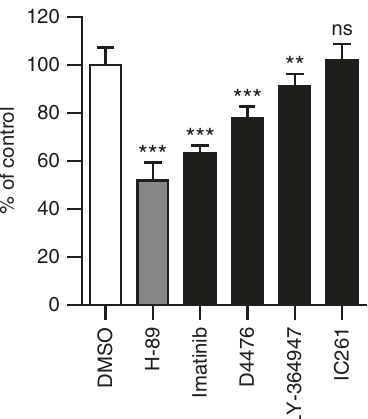
Fig. 1 Veri fi cation of host-directed Mtb inhibitors from literature in the novel screening assay. Overnight treatment of MelJuSo cells infected with Mtb constitutively expressing stable DsRed with compounds that were previously reported to be active against Mtb at 10 µ M or with DMSO at equal v/v. H-89 is used as a positive control at 10 µ M 16 . The Mtb bacterial load is displayed as a percentage of the DMSO control ± standard deviation to indicate the extent of bacterial inhibition. Statistically signi fi cant difference compared to DMSO was tested using a one-way ANOVA. (ns